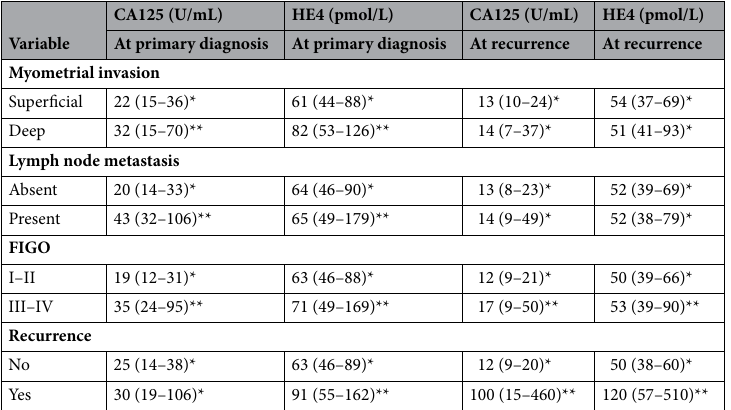
Table 2. Pathological factors in relation to serum levels of HE4 and CA125. Numbers are the median with the interquartile range (IQR). Different superscript symbols (*,**) indicate significant differences between two groups (P < 0.05), either superscript symbols are same mean the difference is not significant (P > 0.05).